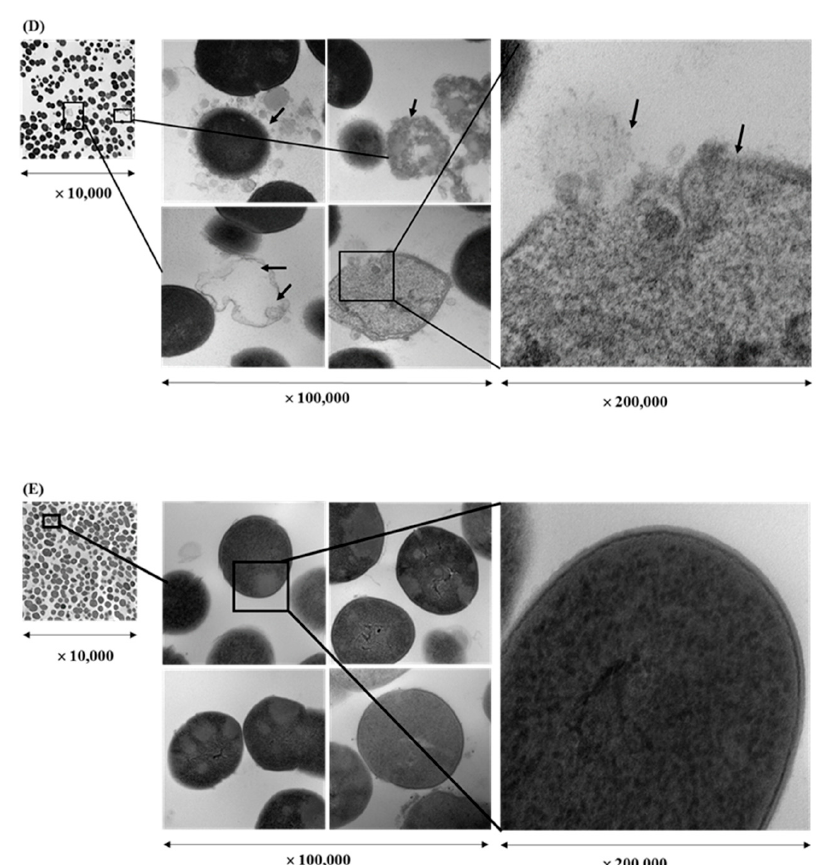
Figure 3. Transmission electron microscope image of a cross-section through Streptococcus pyogenes treated with ethanol extract of different herbs at a sub-inhibitory concentration (1/2 × MIC) for 16 hr: Licorice root ( A ), sage leaf ( B ), purple coneflower flowers ( C ), purple coneflower stems ( D ) extracts, and untreated control ( E ).